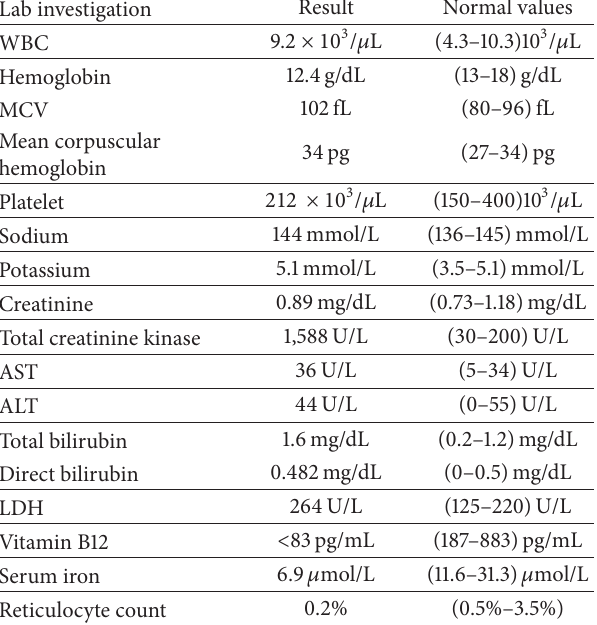
Table 1: Lab investigations at time of